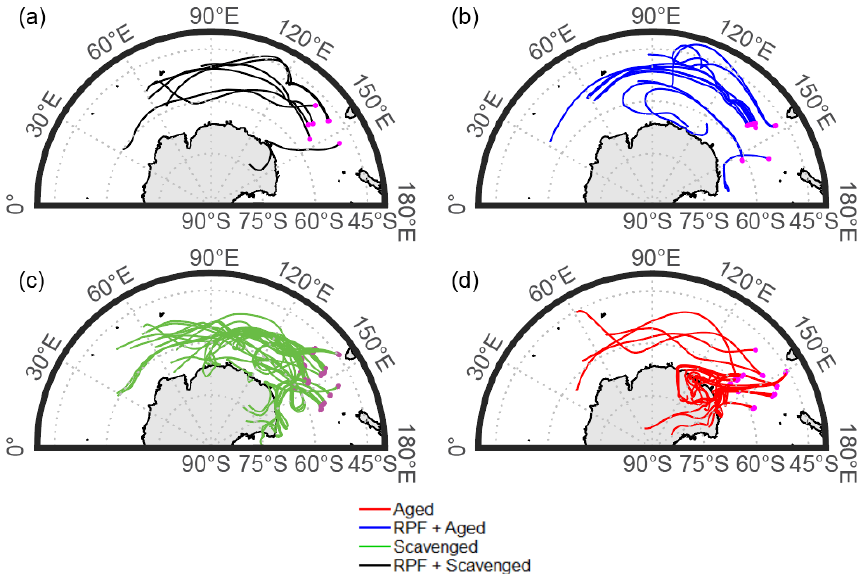
Figure 4. The 5d HYSPLIT back trajectories starting from MBL legs (at 50–500ma.m.s.l., magenta points) for each particle regime.